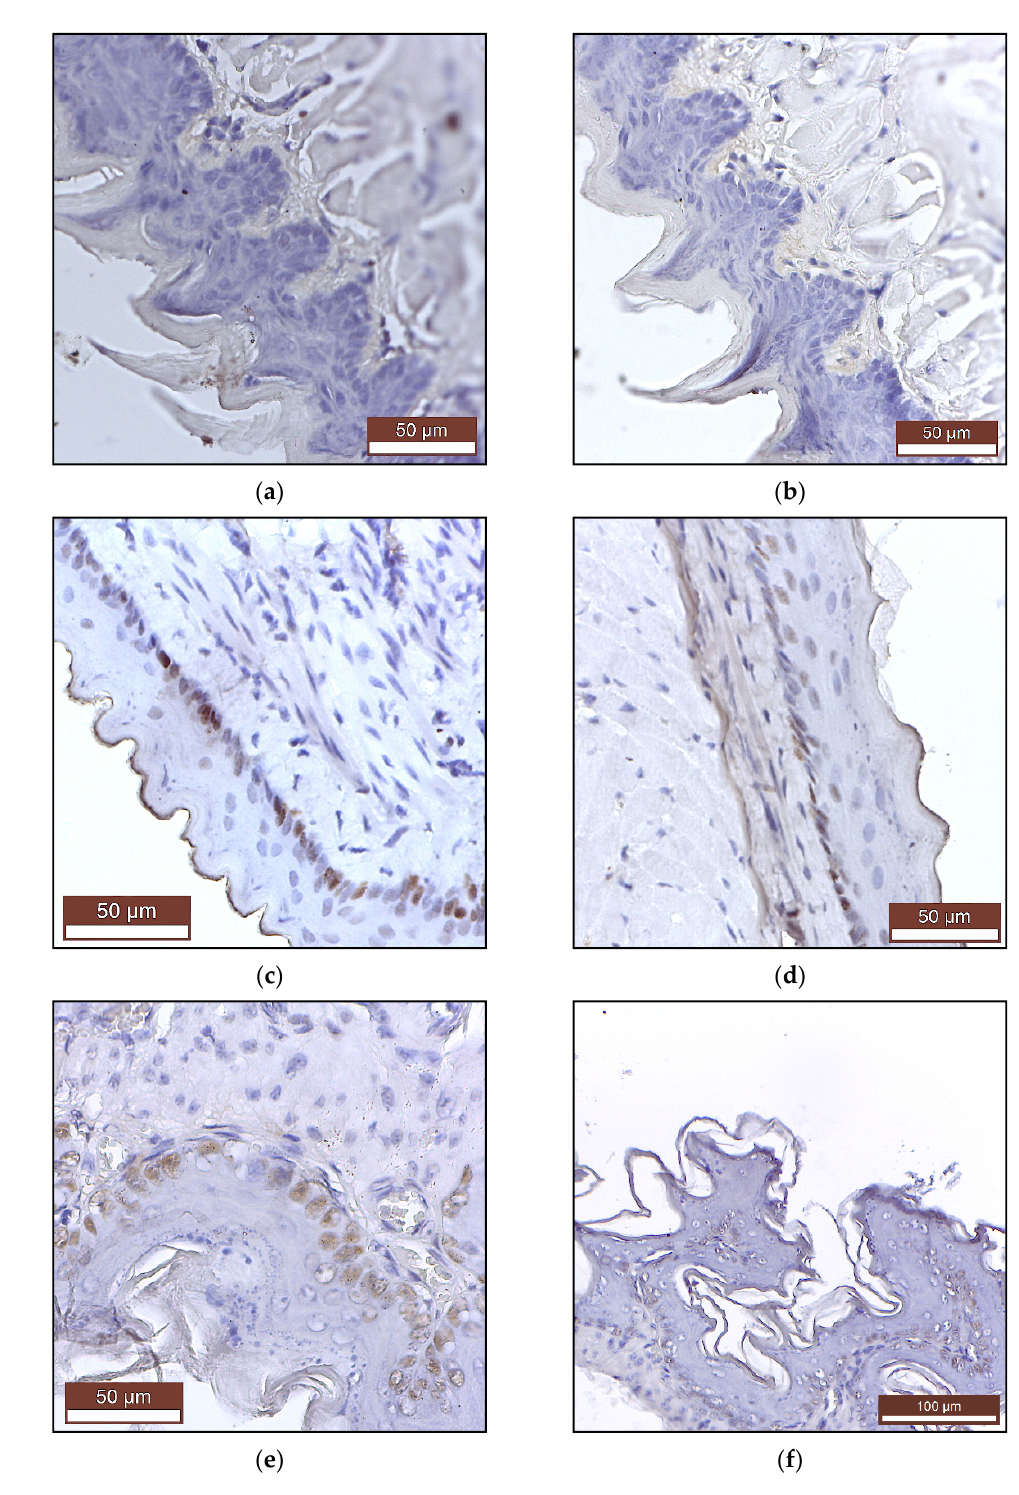
Figure 4. Immunohistochemistry—signals of Ki-67 and PCNA proliferation markers: ( a ) tongue mucosa—Ki-67, ( b ) tongue mucosa—PCNA, ( c ) esophagus mucosa—Ki-67, ( d ) esophagus mucosa—PCNA, ( e ) gastric keratinized mucosa—Ki-67, ( f ) gastric keratinized mucosa—PCNA.